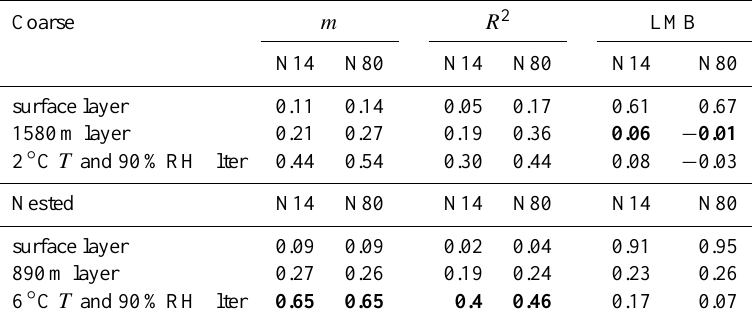
Table 2. Summary of the slope of the linear regression ( m ), correlation ( R 2 ) , and log-mean bias (LMB) for coarse and nested simula- tions. These statistics are found by comparing the average values of the aerosol number concentrations during the measurement period to measurements at Whistler Peak. Bolded numbers represent the best statistical result between all simulations. Coarse m R 2 LMB N14